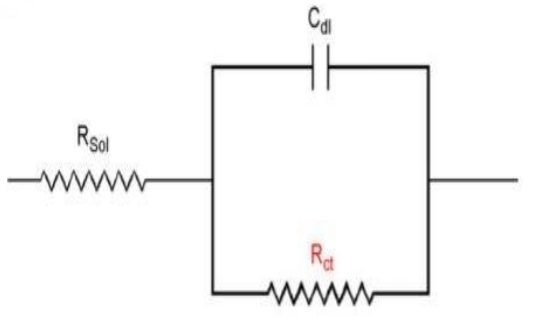
Fig. 2. Randle circuit in Impedance